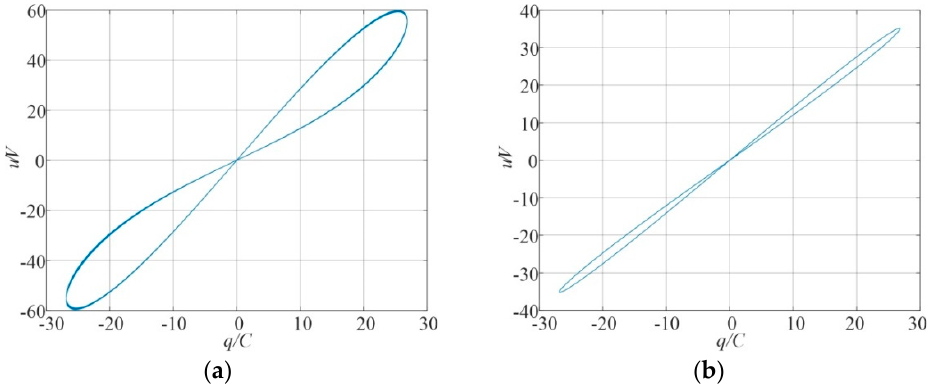
Figure 1. Characteristic curve of the smooth memcapacitor. ( a ) d = 1, c = 2, f = 20 Hz, ( b ) d = 1, c = 2, f = 50 Hz.